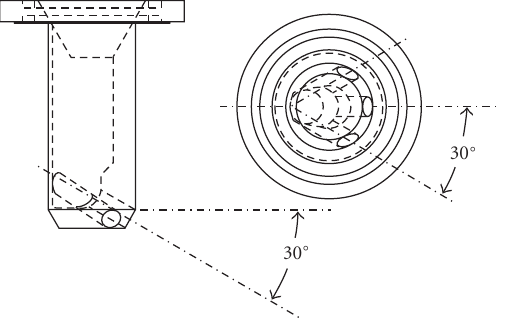
Figure 2: Injector design [19].